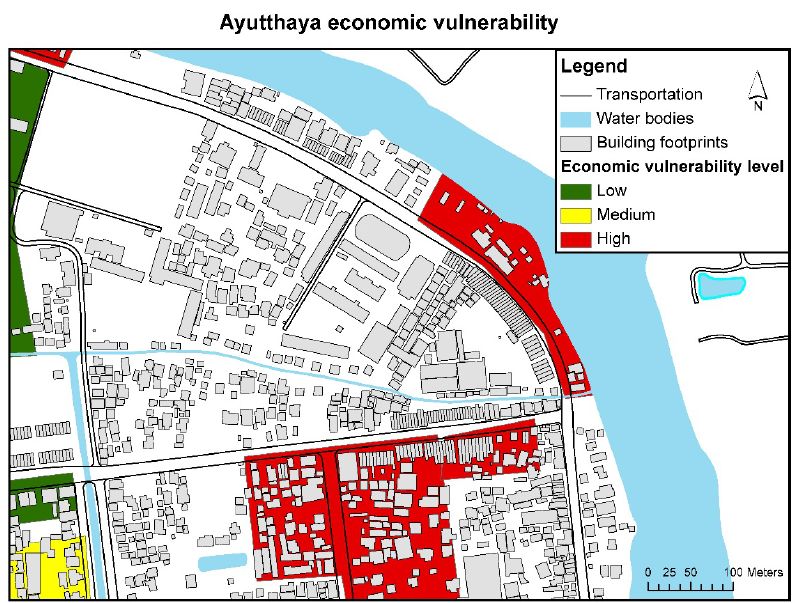
Figure 10. Illustration of the economic vulnerability of the Ayutthaya commercial zones to floods. Categorization is based on the type of services offered with respect to the tourist